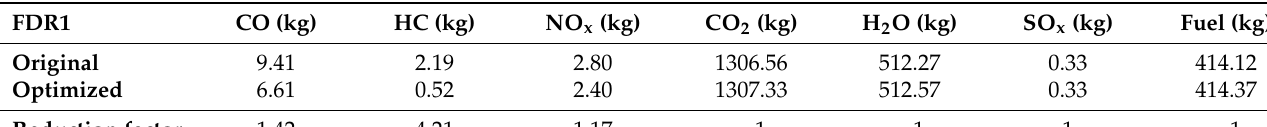
Table 5. Comparison of total level of emissions and fuel burned for FDR1 trajectory: original and optimized.